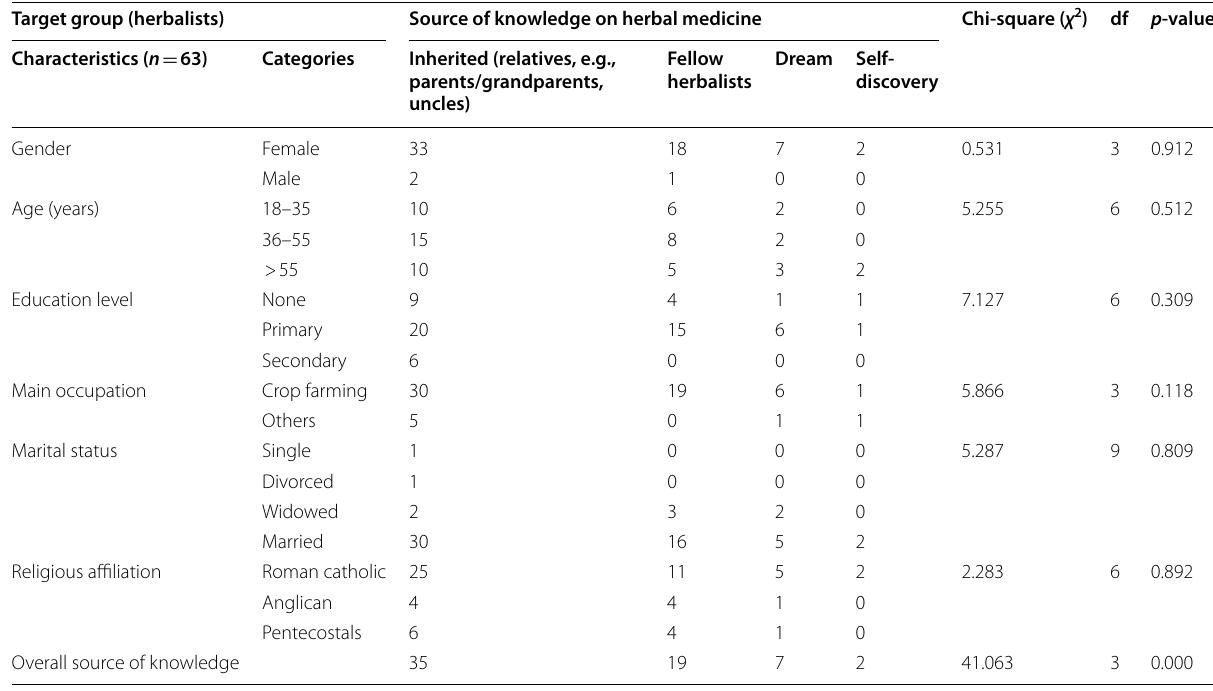
Table 4 Target group versus source of information on herbal medicine Target group (herbalists)